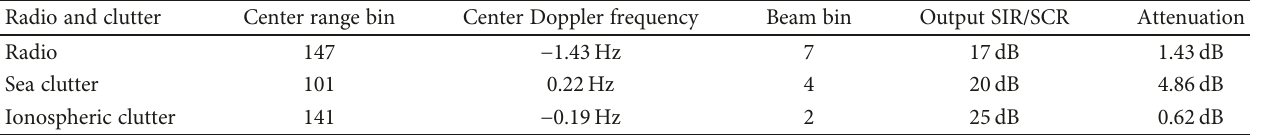
Table 6: Injected target 2